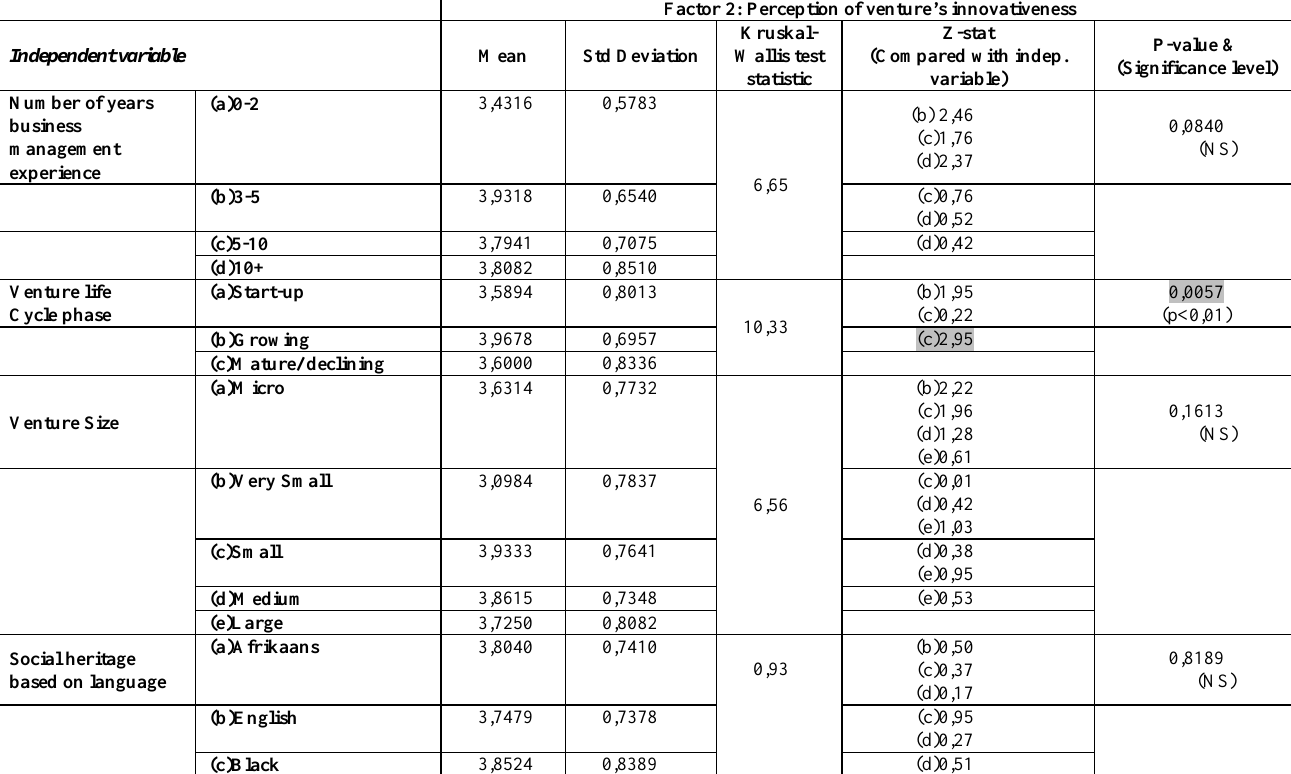
Table 4: Pair-wise analysis of perception of venture’s innovativeness with independent variables Factor 2: Perception of venture’s